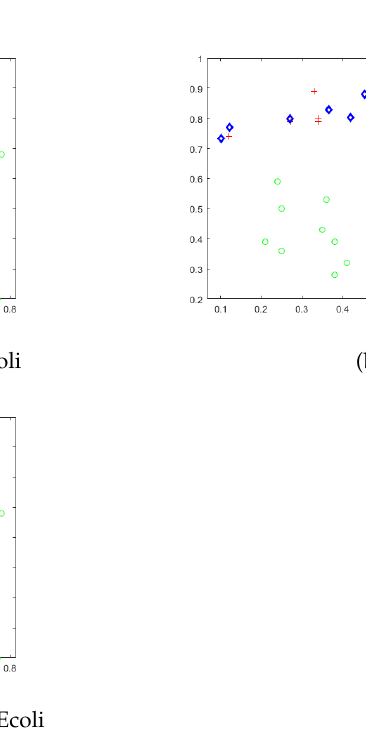
Figure 3. Synthetic objects (blue diamonds) generated by SMOTE ( a ), NDO ( b ), and Fast-SMOTE ( c ) over a 2-D projection of the dataset Ecoli. Green circles represent objects of the majority class, and red crosses represent objects of the minority class. Table 1. Mode values of x and y axis for for Figures